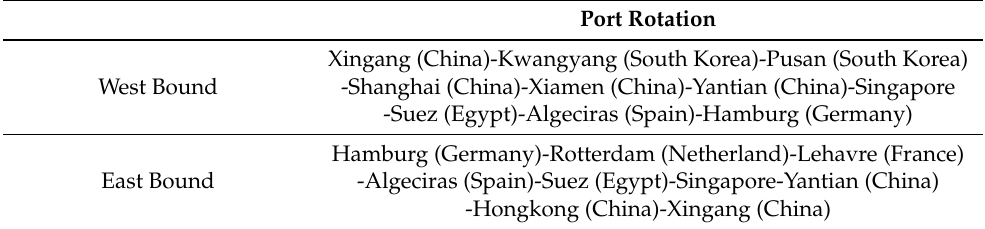
Table 2. Voyage schedule of the target